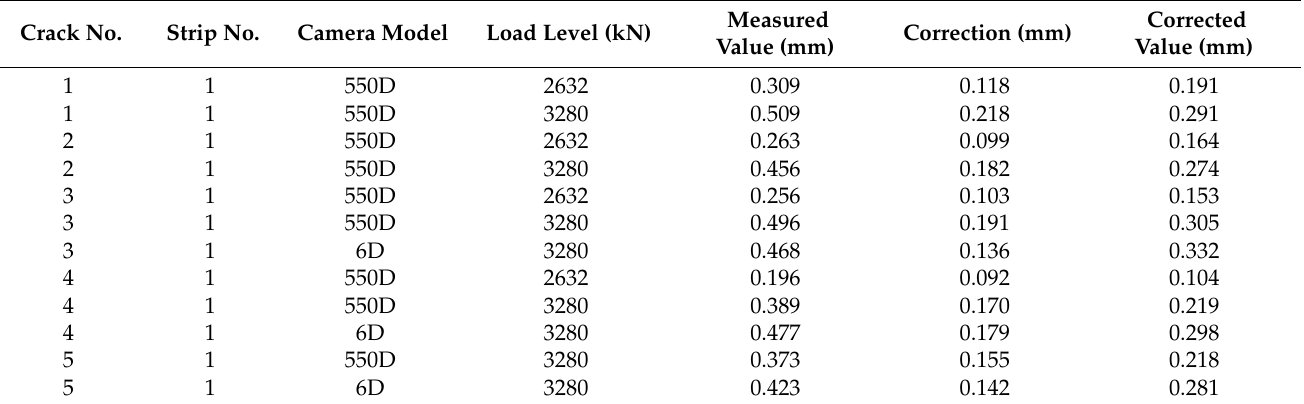
Figure 19. Crack widths at crack detection for Strip 1. The measured crack widths and corresponding corrections are shown in Table 3 for Strip 1. At 2632 kN, crack widths 1–4 (Canon 550D) measure between 0.196 mm and 0.309 mm before correction and 0.104 mm and 0.191 mm after correction, which is slightly higher than for the lab test at crack detection. At 3280 kN, the same cracks measure between 0.219 mm and 0.305 mm after correction, which is an increase of approximately 0.1 mm. Using the Canon 6D images, crack widths 3–5 measure between 0.281 mm and 0.332 mm, which is slightly higher than the Canon 550D results. Table 3. Measured and corrected crack widths at crack detection—Strip 1.